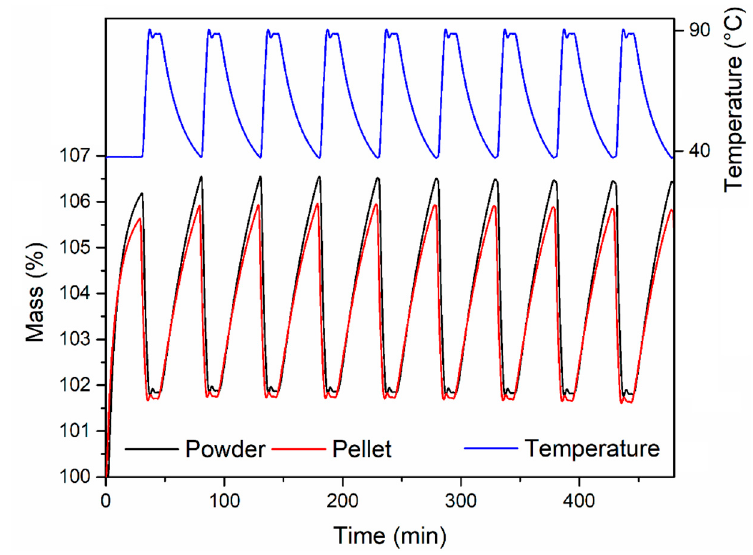
Figure 11. Cyclic CO 2 uptake experiments for MOF-801 free-flowing powder (black) and the pellet containing 5 wt % PVB prepared by compressing for 15 s under 146 MPa pressure (red). The entirety of the experiments were performed under 1 atm CO 2 .